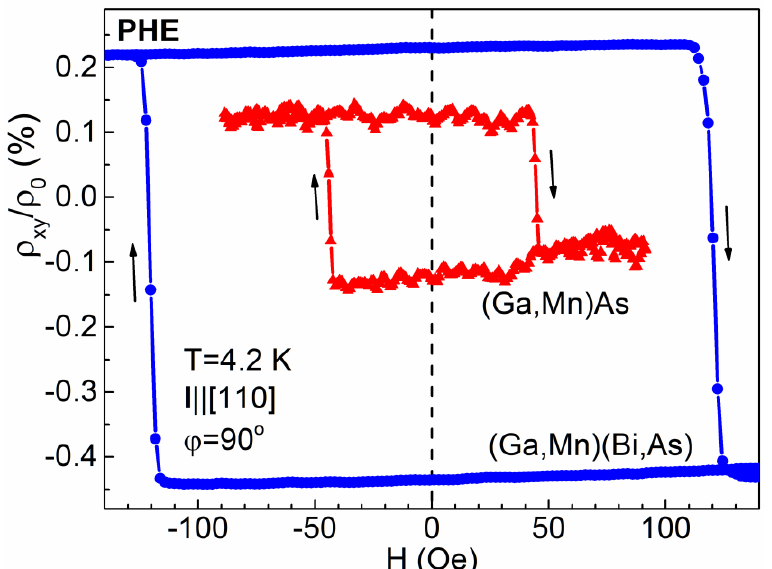
Figure 3. Same as in Figure 2 but measured for a narrower range of sweeping magnetic field after previously magnetizing the Hall-bar at the positive field of 600 Oe. Results obtained for a Hall-bar of the reference (Ga,Mn)As layer are also shown for comparison.